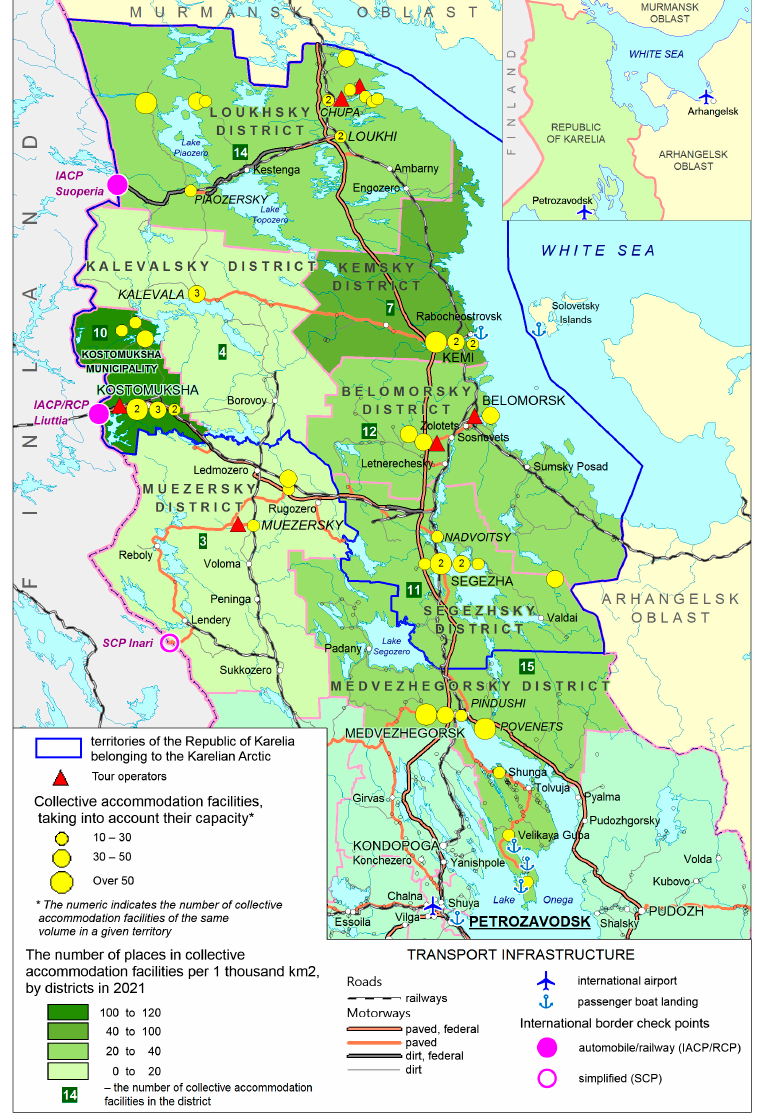
Figure 1. Infrastructure of the tourist and recreational system of the Karelian Arctic and economically related regions.